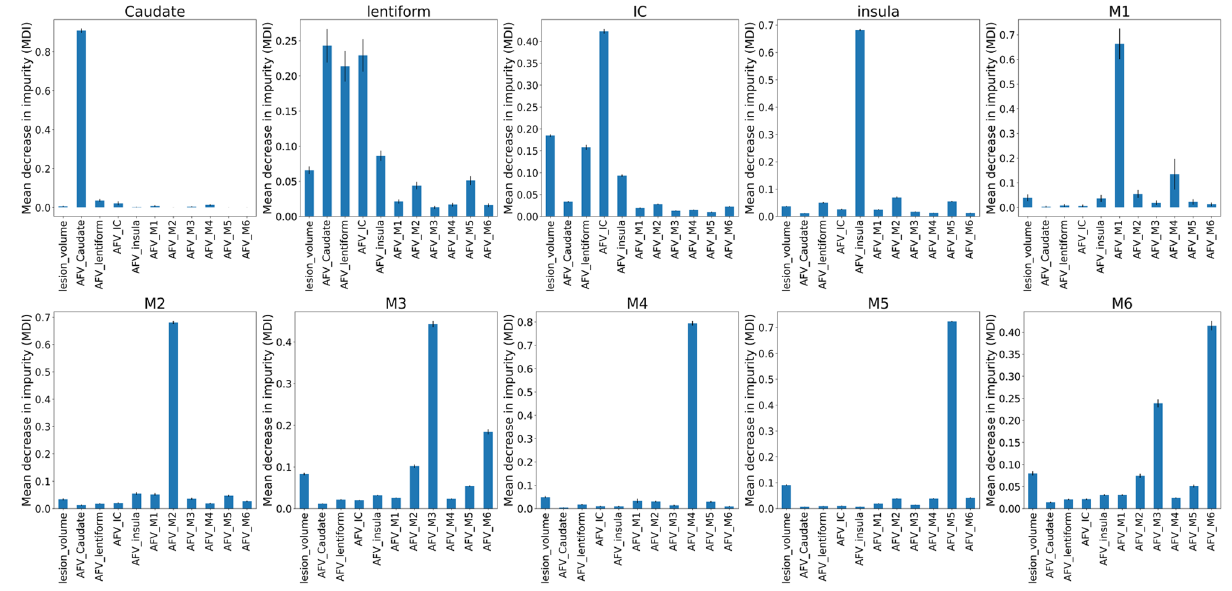
Figure 6. Feature importance, as revealed by the Mean Decrease in Impurity (MDI) of the Random Forest (RF) models. The MDI is proportional to the importance of the features (the AFVs and lesion volume, in the x-axis) to predict the injury of the region in question (title of each graph). The AFVs represent the proportion of each ROI affected by the infarct. Note that the dominant AFV component agrees with the prediction of injury in the corresponding region and is followed by the AFV component of its spatially neighboring